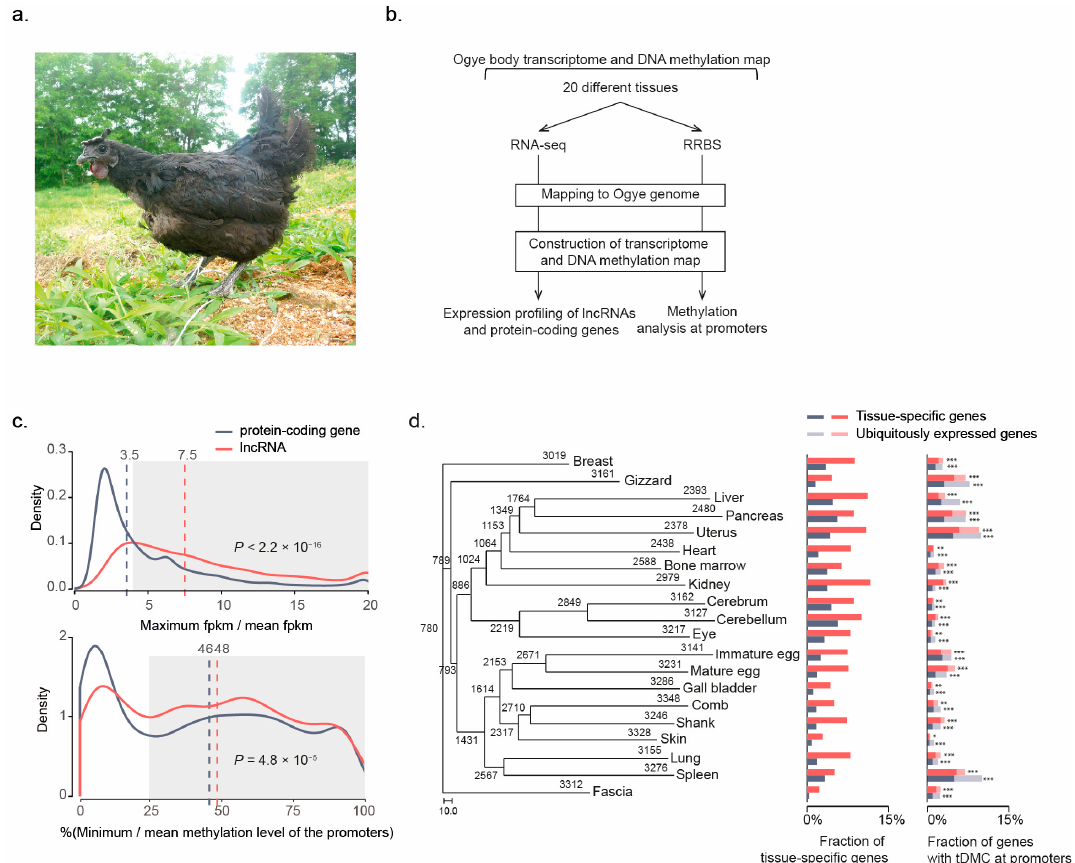
Figure 1. Expression and DNA methylation landscapes of Ogye lncRNAs. ( a ) Yeonsan Ogye. ( b ) A schematic flow for the analyses of coding and non-coding transcriptomes and DNA methylation from 20 different tissues. ( c ) Distributions of the maximum versus mean expression values of lncRNA (red line) and protein-coding genes (black line) across tissues (top), and distributions of the minimum versus mean methylation levels of each cytosine in the promoter of lncRNAs (red line) and protein-coding genes (black line) (bottom). The vertical dotted lines indicate the median value of the respective distribution (black for protein-coding genes and red for lncRNAs). The gray boxes indicate tissue-specific expression and methylation ( d ) Numbers of commonly or uniquely expressed lncRNAs across tissues are shown in the phylogenetic tree of tissues. The numbers at the leaf nodes indicate lncRNAs expressed in the indicated tissue (FPKM ≥ 1) and numbers at the internal nodes indicate those commonly expressed in the indicated tissues. Of the expressed genes in a certain tissue, the fraction of tissue-specific genes (red for lncRNA and black for protein-coding genes) and fraction of genes with a differentially methylated region (DMR) in the promoters are indicated as bar graphs. Of the genes with a DMR, tissue-specific genes (dark) and others (light) were distinguished and the enrichment of tissue-specific genes was tested using Fisher’s exact test (* p ≤ 1 × 10 − 5 , ** p ≤ 1 × 10 − 10 , *** p ≤ 1 × 10 − 20 ). The scale bar represents 10.0, which is the unit of 120 differentially expressed genes across tissues.